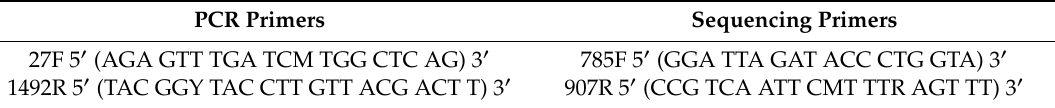
Table 3. Primers used for PCR as well as 16S rRNA